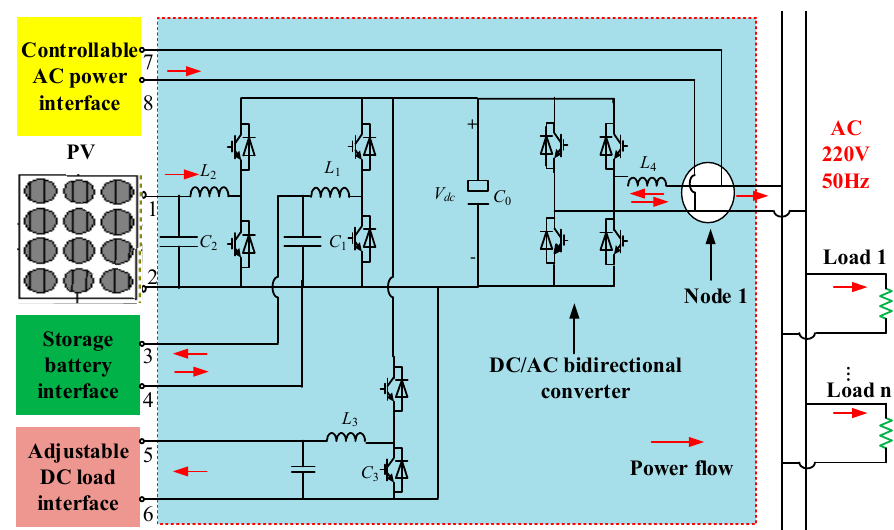
Figure 12. Power flow of SPEER in isolated network Figure 1.